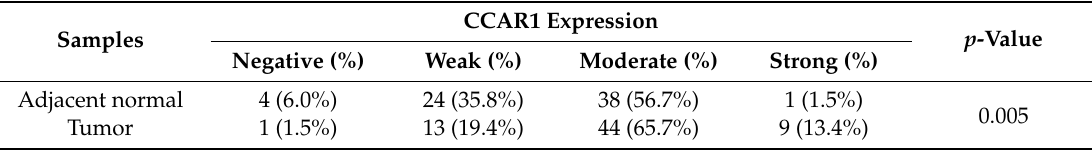
Figure 5. CCAR1 expression in human gastric cancer and matched adjacent normal tissues. ( A ) Representative images of immunohistochemical (IHC) staining for CCAR1 on the sections of gastric cancer tissues and their normal mucosa are shown. Scale bar: 40 µm ( B ) Scatter plot depicting CCAR1 levels as assessed by IRS (0–1 = negative staining; 2–3 = weak staining; 4–6 = moderate staining; 8–12 = strong staining) in tumors and adjacent normal tissues. Data are presented as the mean with error bars representing the S.D. The p -value was determined by an unpaired test. The symbol *** indicates p < 0.001; ( C ) Bar charts showing the percentage of cases that demonstrated staining with different levels of CCAR1 in tumors and adjacent normal tissues. Table 1. The Fisher’s exact test of the IHC staining of 67 cases of the paired gastric cancer specimens on TMA chips.